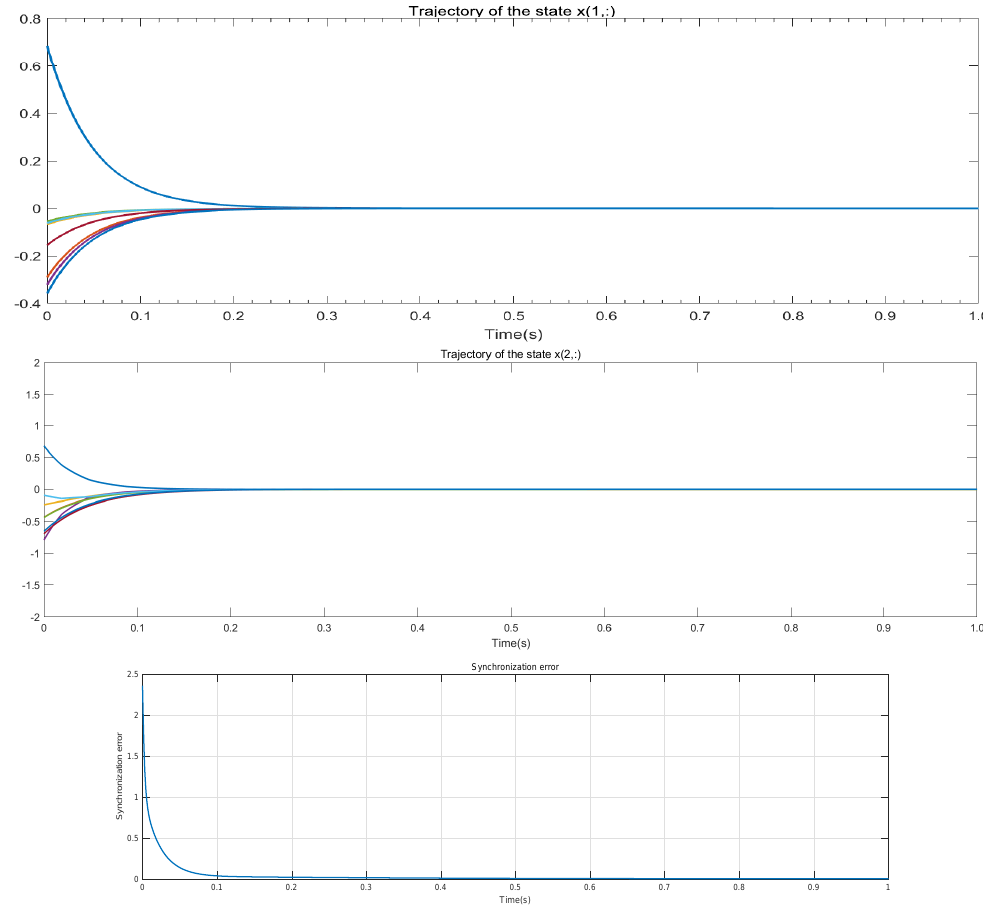
Figure 3. Trajectory using network-partitioning